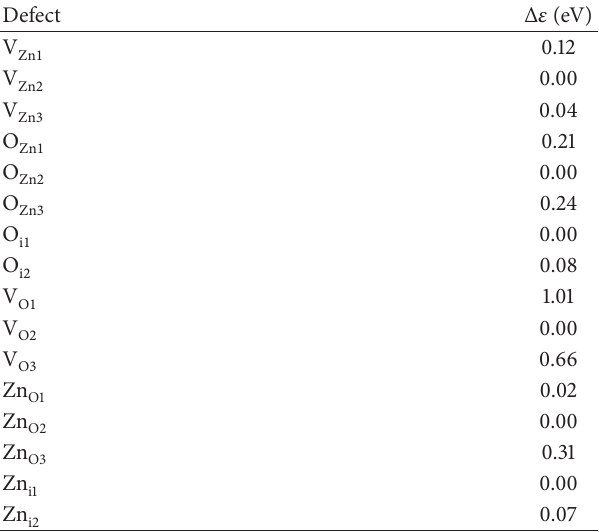
Table 1: Calculated relative energy Δ𝜀 for the ZnO nanowire with different point defects (with the ground state energy taken as the reference